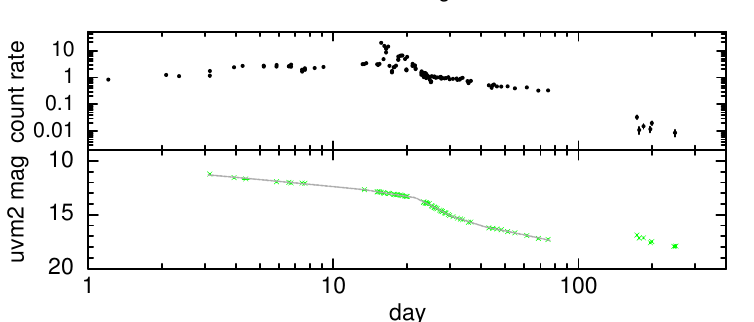
Figure 11. The XRT and UVOT light-curves of V3890 Sgr, with the best-fit broken power-law decline shown as the grey solid line. uvw 2 data were only collected until day 25, so have not been included. Late-time data after day 100 have been excluded from the fits. The X-ray data (top) are in count s − 1 over 0.3–10